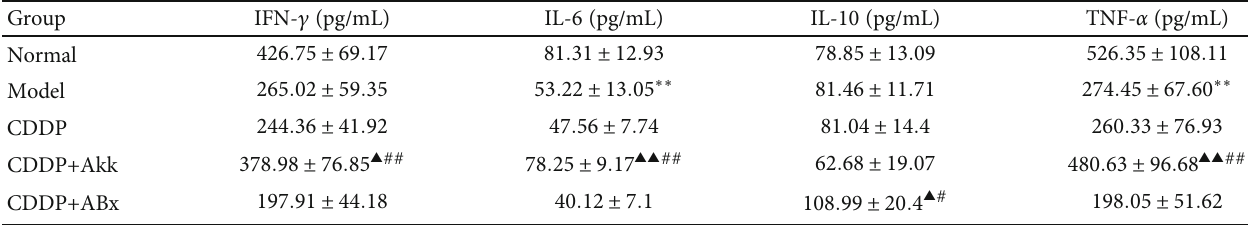
Table 4: The levels of IFN- γ , IL-6, IL-10, and TNF- α in the mouse serum ( mean ± SD , n = 10 ). Group IFN- γ (pg/mL)